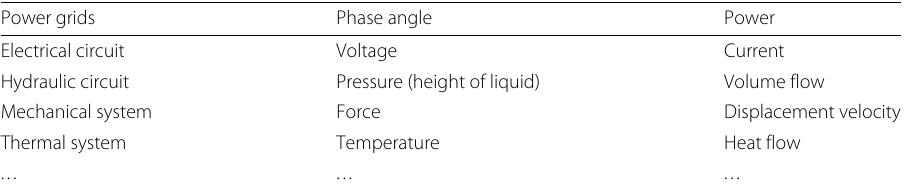
Table 1 Equivalence between linear systems, adopted from (Van Mieghem et al. 2017) Power